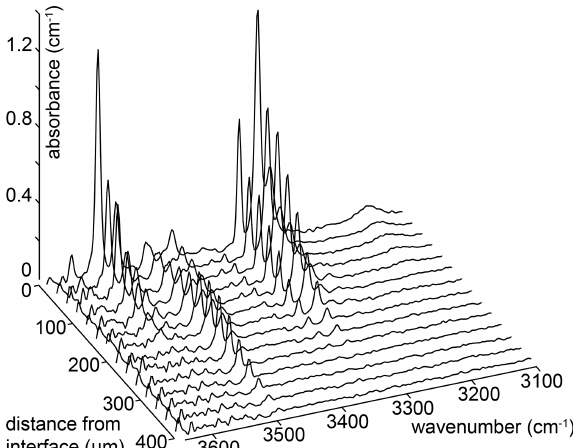
Figure 5. An example of a series of FTIR spectra recorded as a function of distance from the crystal edge. The number of spectra in the series has been reduced by a factor of 3 for clarity. These spectra are from sample HYCRa3 (850 ◦ C, Ni–NiO, 1.5GPa, fo- en,